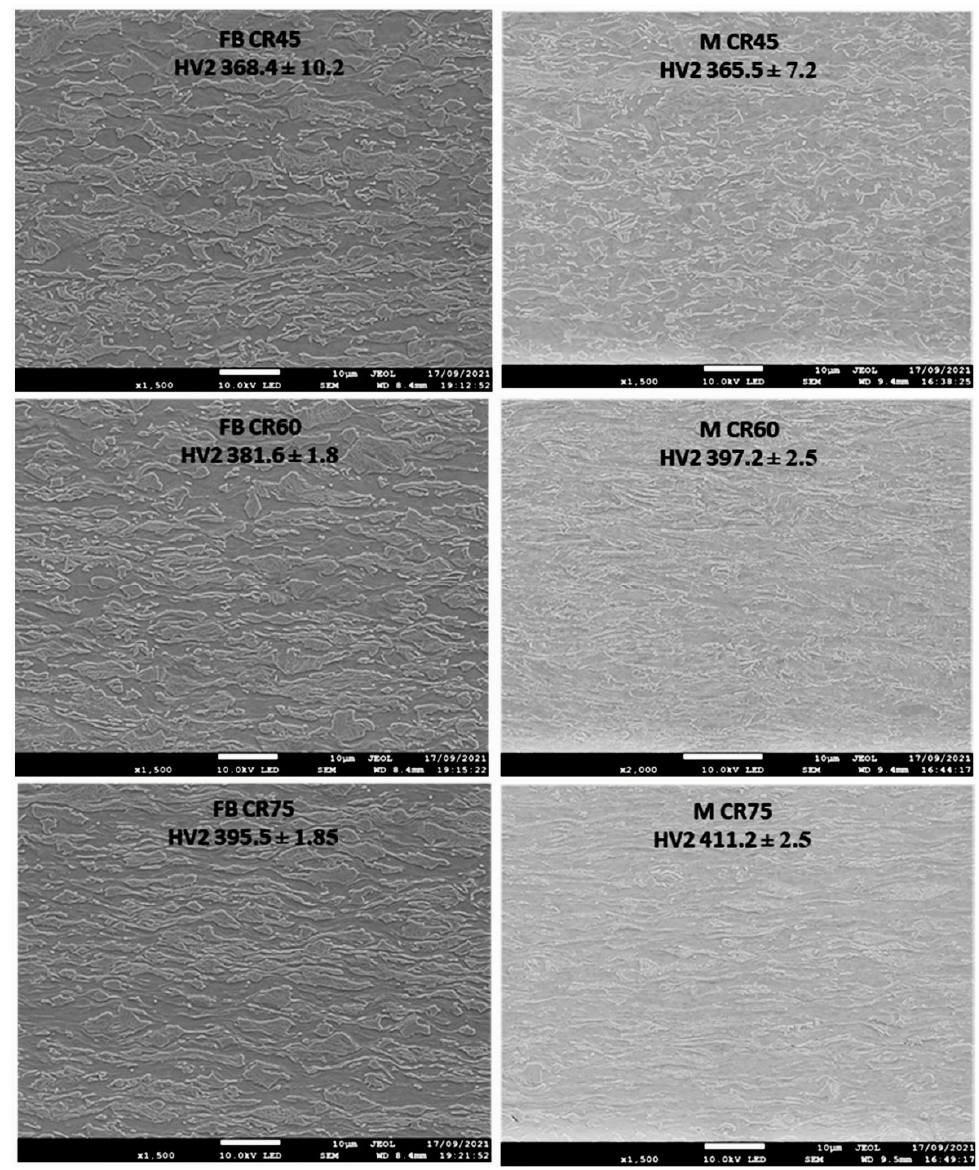
Figure 7. SEM micrographs of the cold rolled 45%, 60% and 75% samples for ferrite–50% bainite and fully martensite/bainite microstructures in Variant 2.